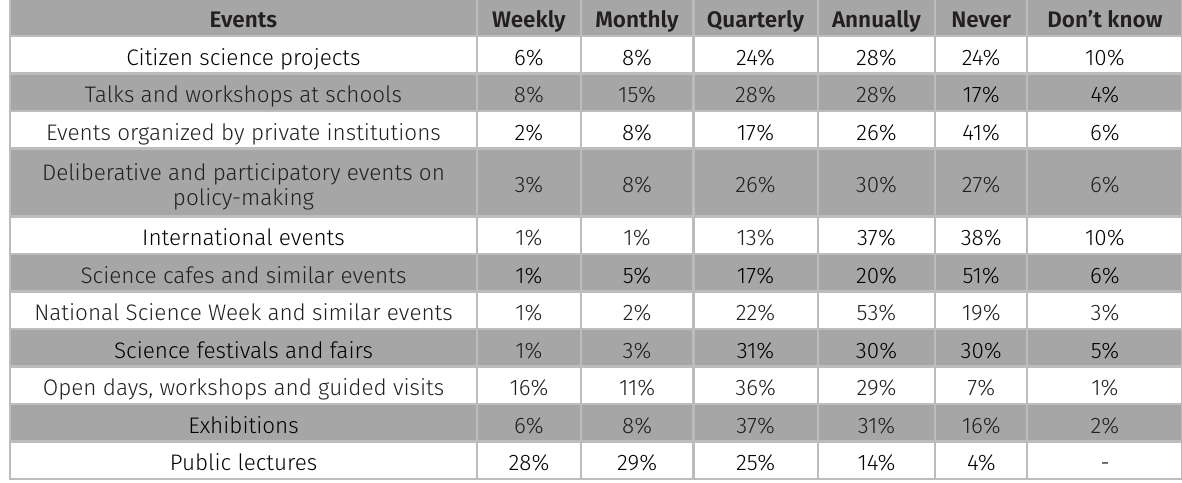
Table III. Frequency of different science communication